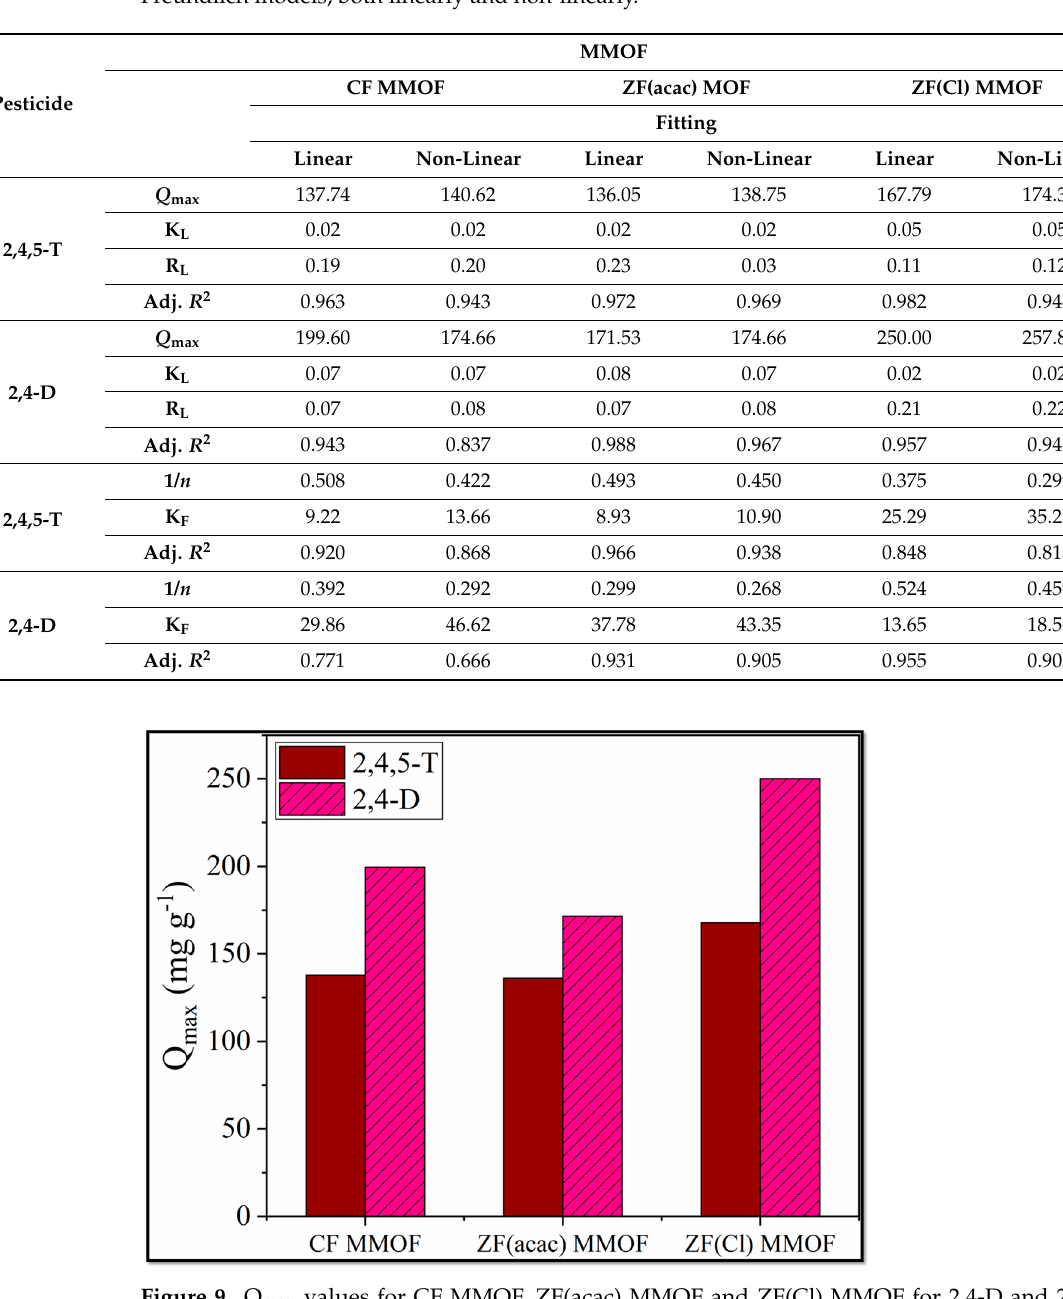
Figure 9. Q max values for CF MMOF, ZF(acac) MMOF and ZF(Cl) MMOF for 2,4-D and 2,4,5-T pes- ticides.